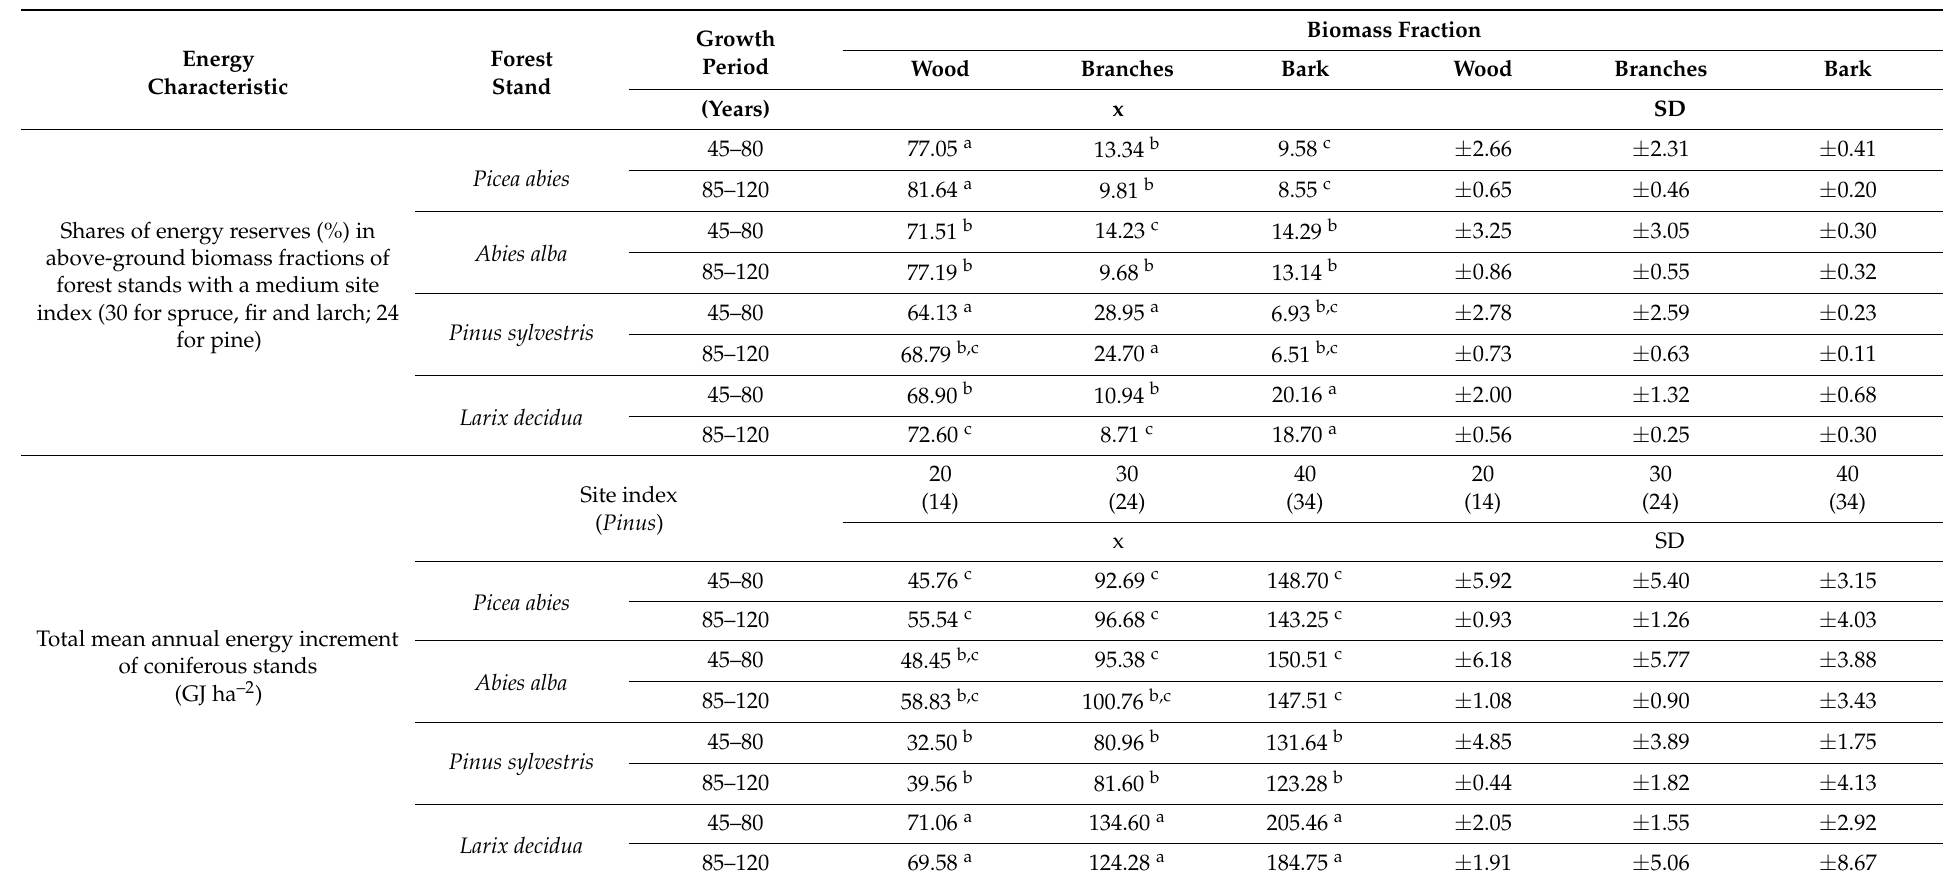
Table 7. Variability of energy characteristics of coniferous stands. ANOVA, Tukey’s test. Significantly different mean values ( p < 0.01) of energy characteristics are indicated by different letters ( a,b,c